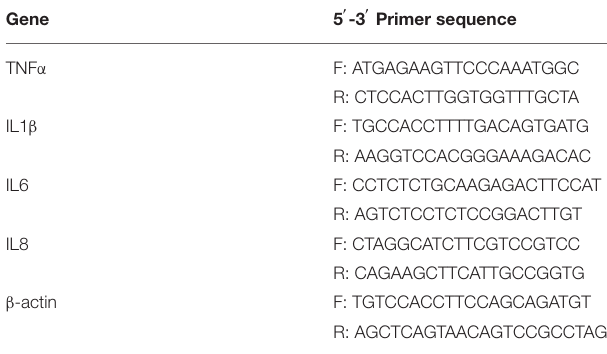
TABLE 1 | Primer sequences for